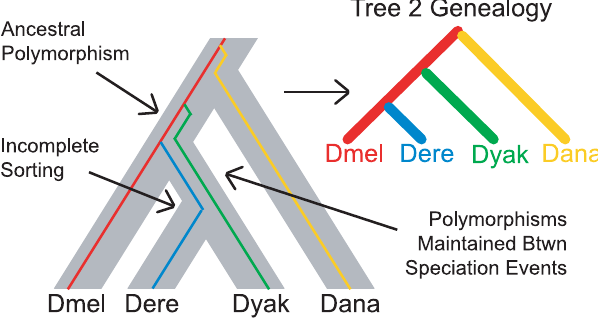
Figure 3. Incomplete Lineage Sorting The history of a gene (colored lines) is drawn in the context of a species tree (gray bars). New lineages arising from new polymorphisms in the gene are drawn in different colors. In this case, the two alleles in the population prior to the split of Dmel are maintained through to the split of Dere and Dyak, leading to incomplete lineage sorting and an incongruent genealogy (tree 2). The greater the diversity in the ancestral population and the shorter the time between speciation events, the more likely nonspecies genealogies are. DOI: